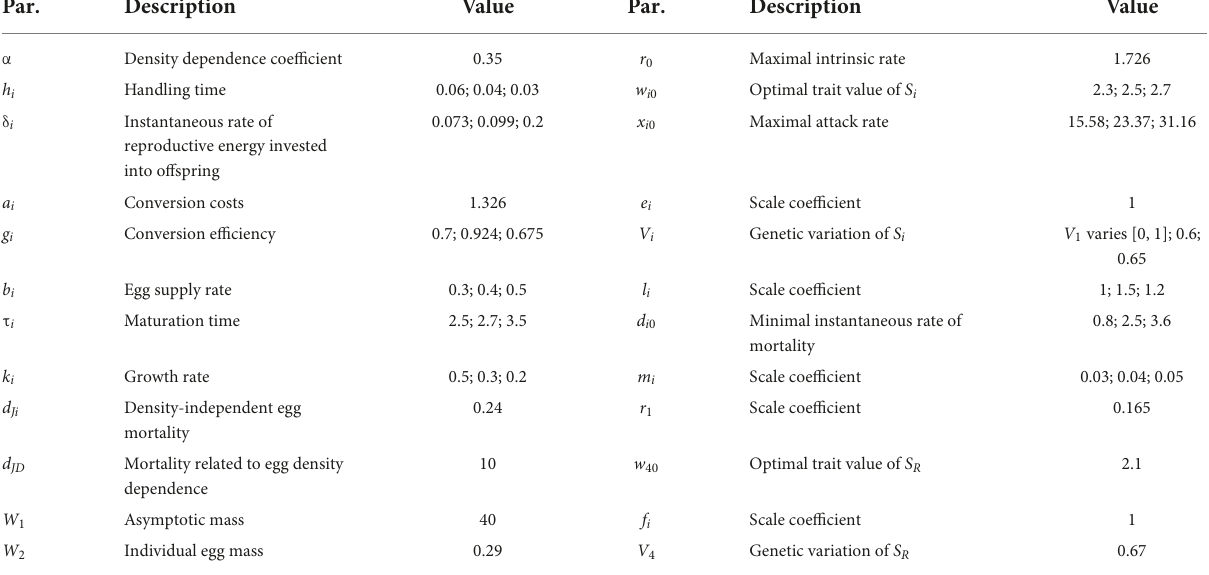
TABLE 1 Parameters used in the eco-evolutionary model.